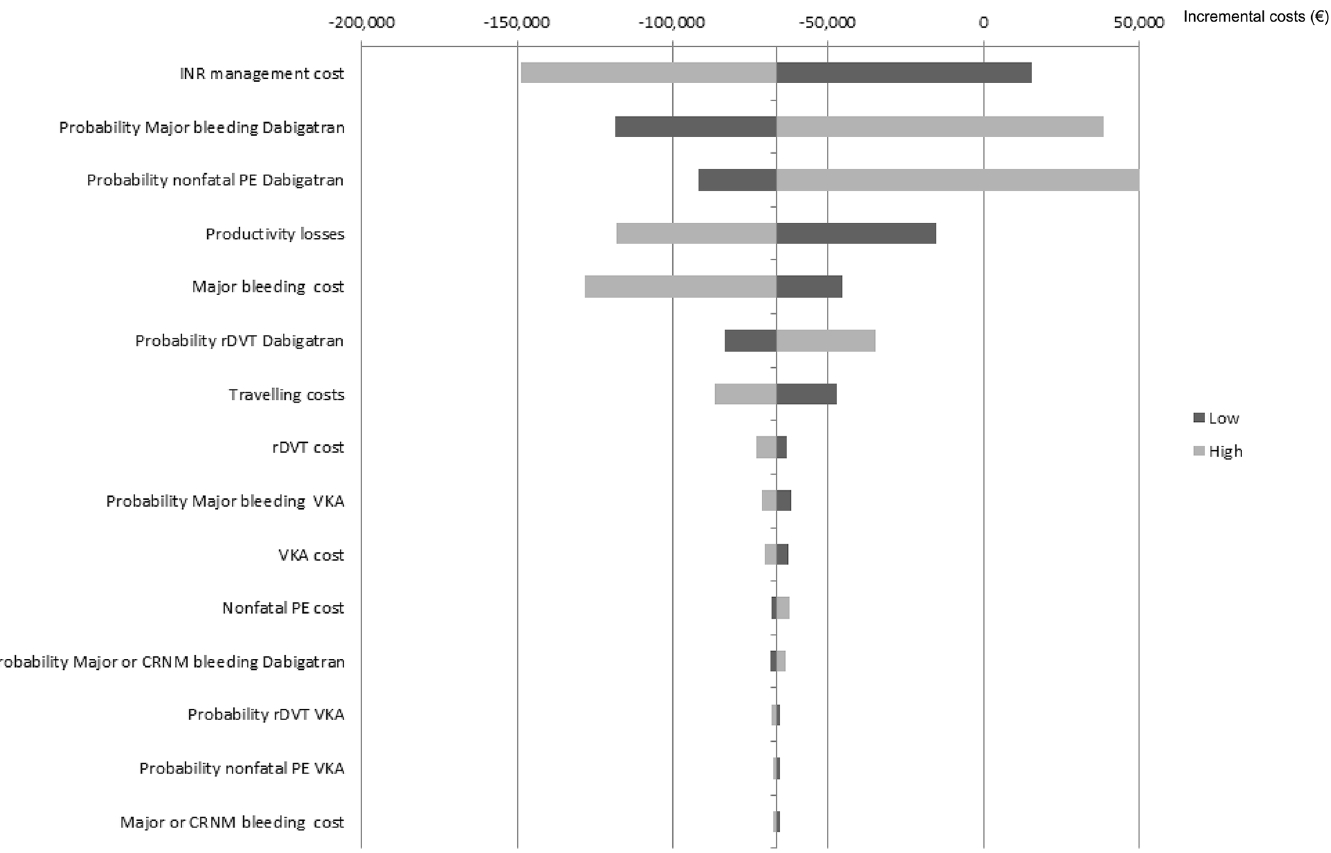
Fig 3. Tornado diagram illustrating the impact on the incremental costs from sensitivity analyses for dabigatran vs. vitamin-K antagonists. Light grey bars denote influence of the high value of the 95% confidence interval range and dark grey bars denote influence of the low value for parameters investigated. The solid vertical line represents the base case incremental costs for dabigatran compared to VKA. Horizontal bars indicate the range of incremental costs obtained by setting each variable to the values shown while holding all other values constant. INR, international normalized ratio; PE, pulmonary embolism; rDVT, recurrent deep vein thrombosis; VKA, vitamin K antagonist; CRNM, clinically relevant non-major.